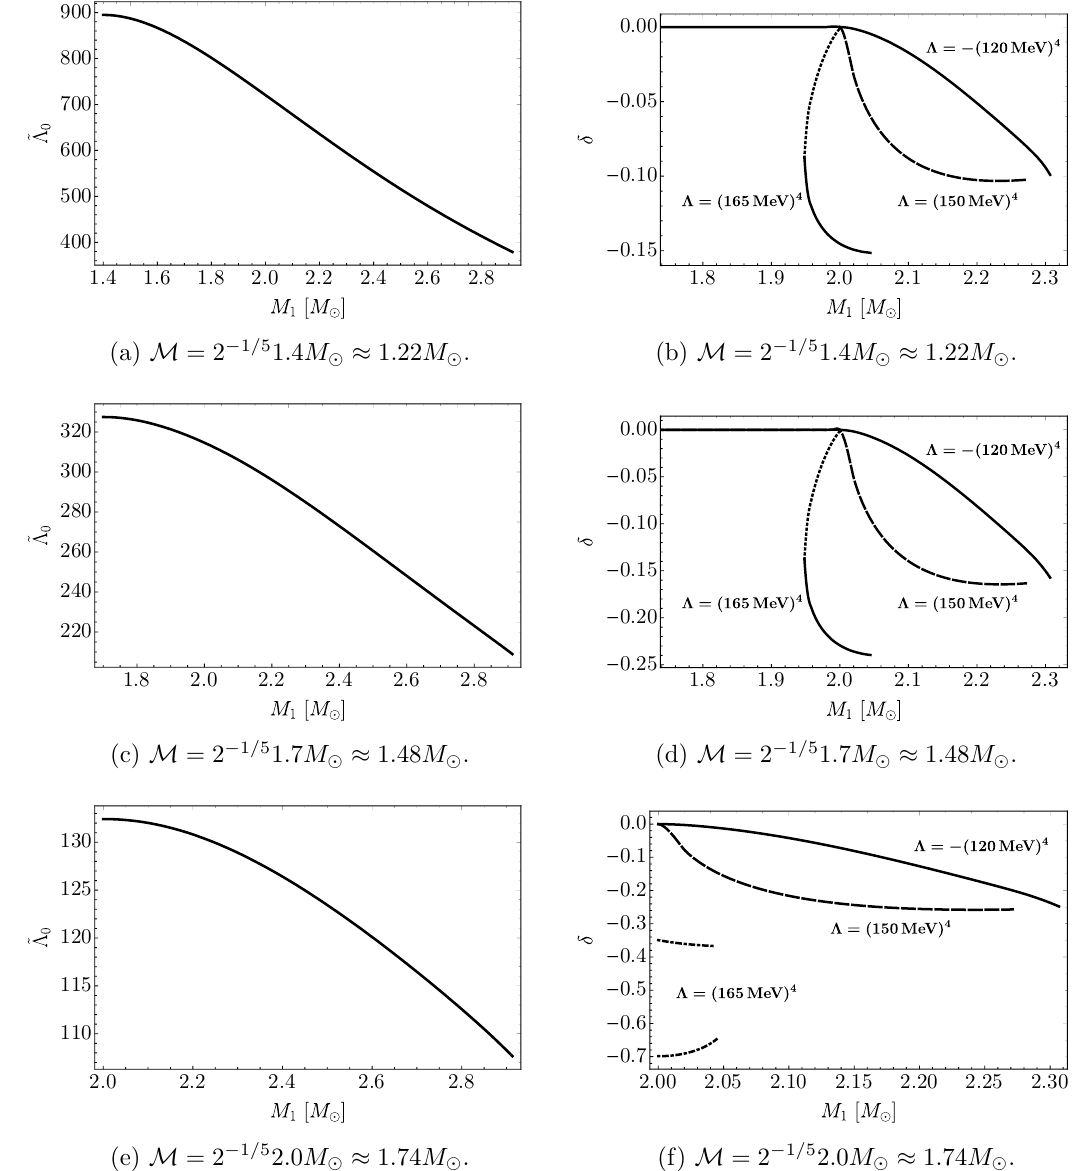
Figure 4. Plots on the right show the relative deviation of the combined dimensionless tidal deformability, ~(cid:3), as a function of the heaviest star mass for the Hebeler et al. parametrization with (cid:11) = 3 for various values of the chirp mass. Plots on the left show ~(cid:3) for vanishing VE for the same chirp masses. Dotted parts of the curves correspond to unstable con(cid:12)gurations. The disconnected branches associated with two stable NS con(cid:12)gurations allow for the largest deviations.